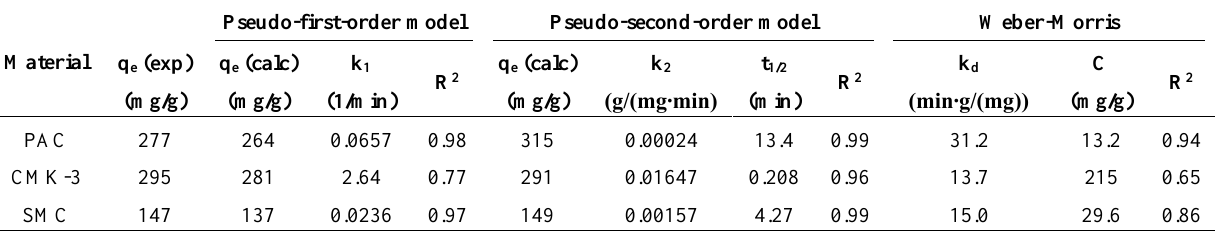
Figure 5. Adsorption kinetics of 100 mg of CMK-3 (■), PAC (●) and SMC (▲) in 1 L of 60 mg/L BPA-solution, particle size is between 62 and 88 µm, the error bars represent the standard deviation of the triplicate measurements, the dashed lines represent the pseudo-second-order kinetic model descriptions. Table 4. Parameters of the pseudo-first-order, pseudo-second-order and Weber-Morris kinetic models for adsorption of BPA on PAC, CMK-3 and